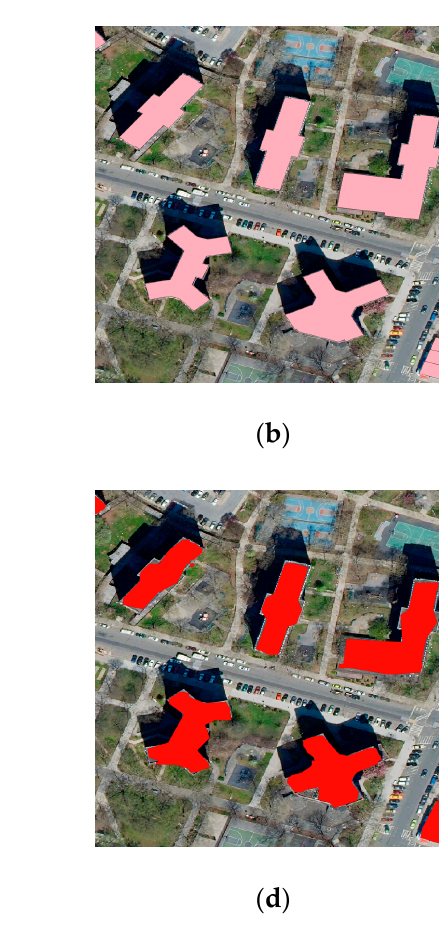
Figure 7. ( a ) Remote sensing image; ( b ) Remote sensing image overlayed with the ground truth mask; ( c ) Remote sensing image overlayed with the Microsoft predicted building footprints; ( d ) Remote sensing image overlayed with the predicted footprints using the proposed workflow based on DeepLabv3+ model (using dicewce loss function).